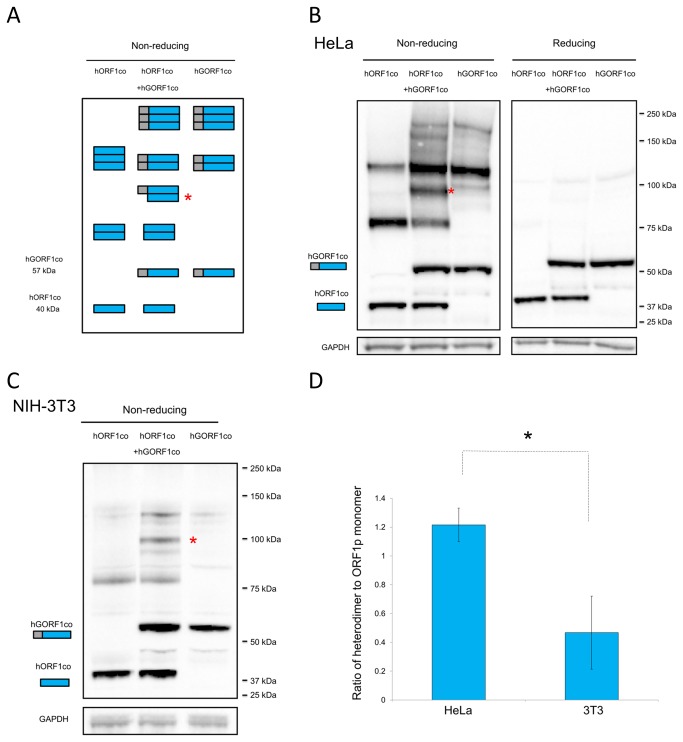
Analysis of ORF1p interactions in
trans.
A. Schematic of predicted ORF1p species expected to be detected if ORF1p heterodimerization takes place when cells are transiently cotransfected with tagged and untagged ORF1p expression plasmids. Blue rectangle represents ORF1, grey rectangle represents a GAL4 tag, with expected molecular weights expressed in kilodaltons (kDa). Red asterisk denotes heterodimers. B. Western blot analysis of ORF1p species expressed by hORF1co (blue rectangle labeled hORF1co) and hGORF1co (grey/blue rectangle labeled hGORF1co) plasmids individually transfected (hORF1co lane and hGORF1co lane) or cotransfected (hORF1co+hGORF1co lane) in HeLa cells. Western blot analysis of ORF1 protein species in HeLa cells under non-reducing (left panel) and reducing (right panel) conditions. Proteins are detected with human specific polyclonal antibodies. GAPDH used as loading control. A molecular weight ladder in kilodaltons (kDa) is presented on right side. Red asterisk indicates an ORF1p heterodimer. C. The same experiment as in B is performed in NIH-3T3 cells. Non-reducing western blot conditions are shown. Red asterisk denotes ORF1p heterodimers. D. Quantitation of western blot results from B and C using heterodimer/ORF1p monomer ratio. Statistical significance is indicated by dashed lines. An asterisk indicates statistically significant difference (T-test, p-value<0.05).